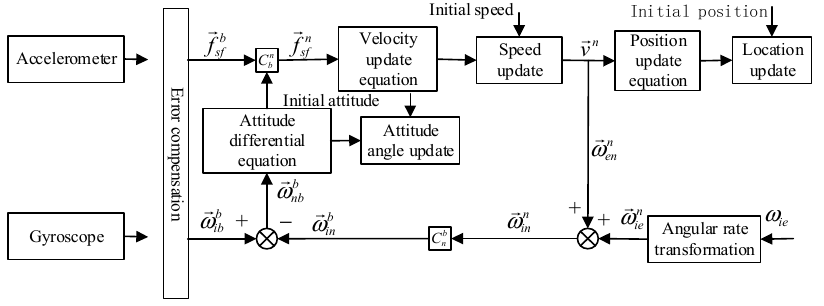
Figure 2. Schematic diagram of inertial navigation solution.